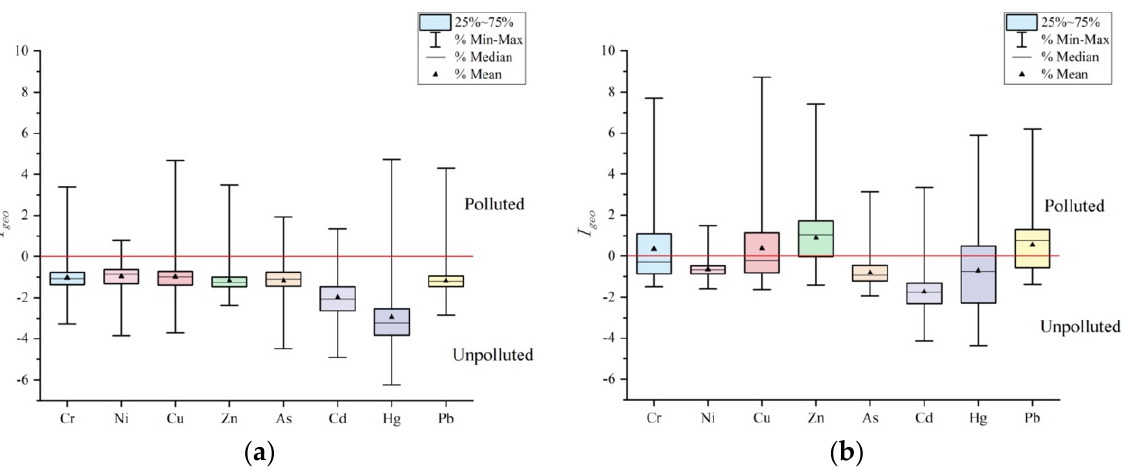
Figure 6. I geo of laboratory concentration of samples in pXRF low-value ( a ) and high-value datasets ( b ).